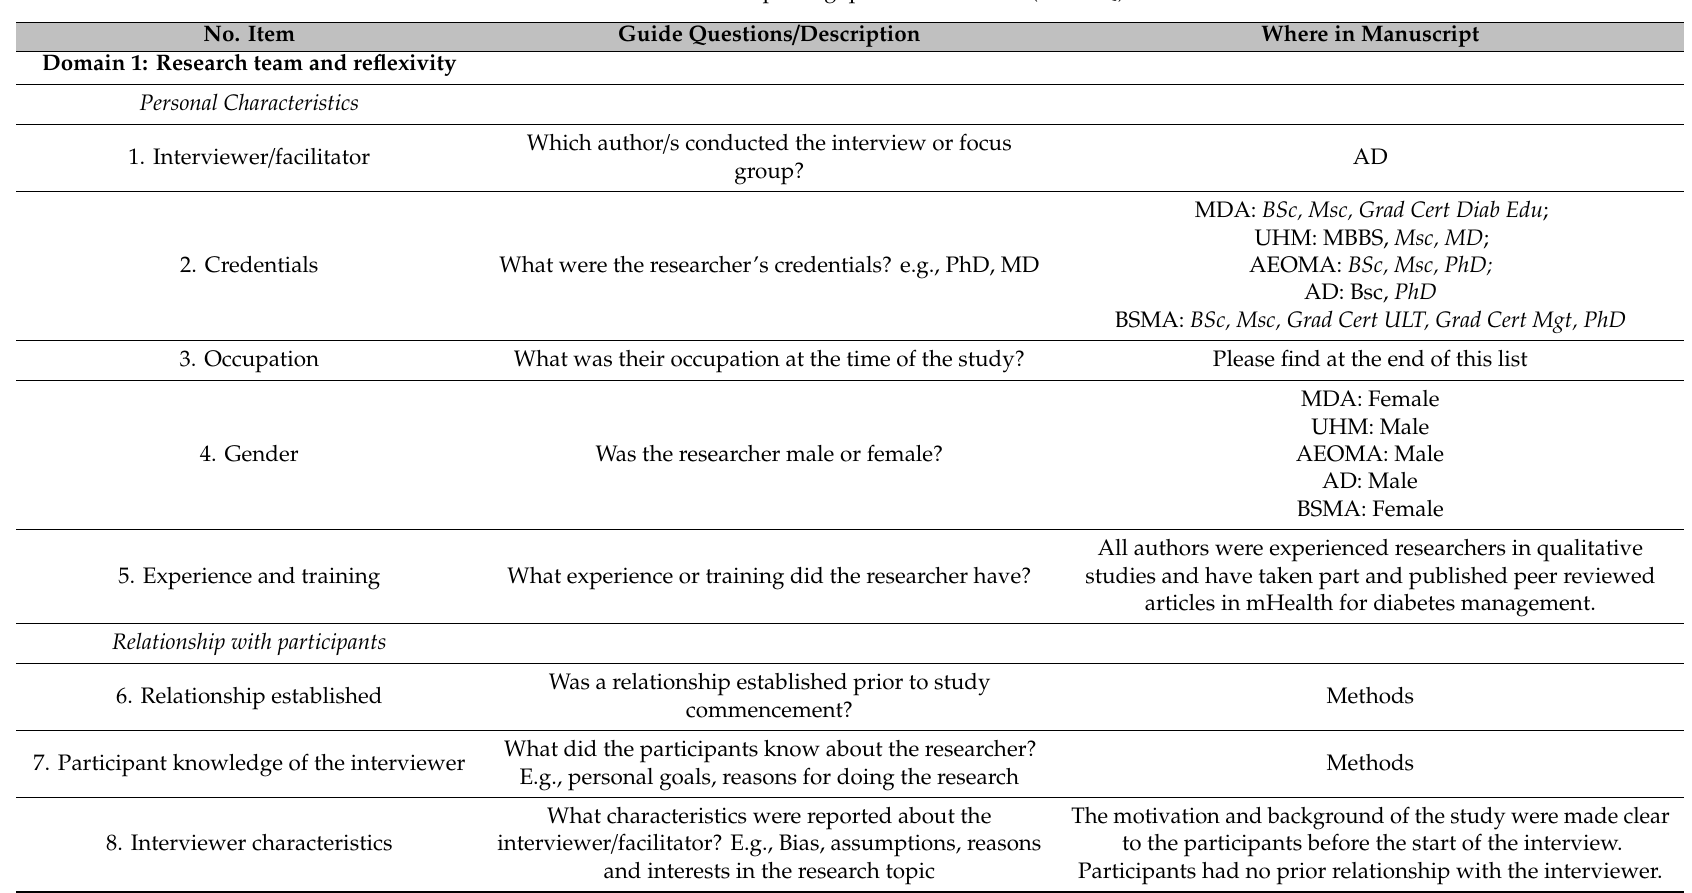
Table A1. Consolidated criteria for reporting qualitative studies (COREQ): 32-item